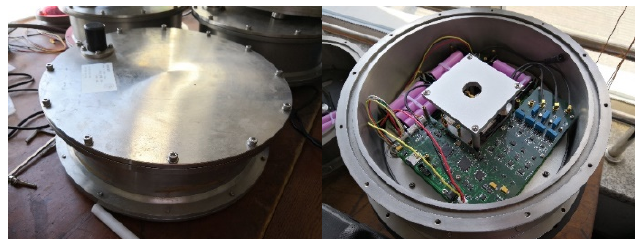
Figure 33. Design of a cylindrical double-tank OBS made up of titanium alloy.